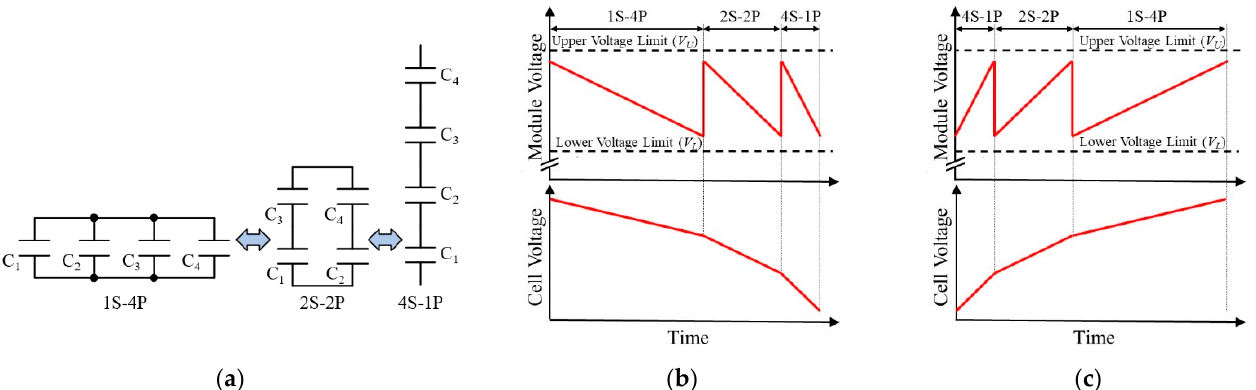
Figure 3. ( a ) Typical reconfiguration sequence of balance-shift circuit for four-cell module, and its ( b ) discharging and ( c ) charging profiles.